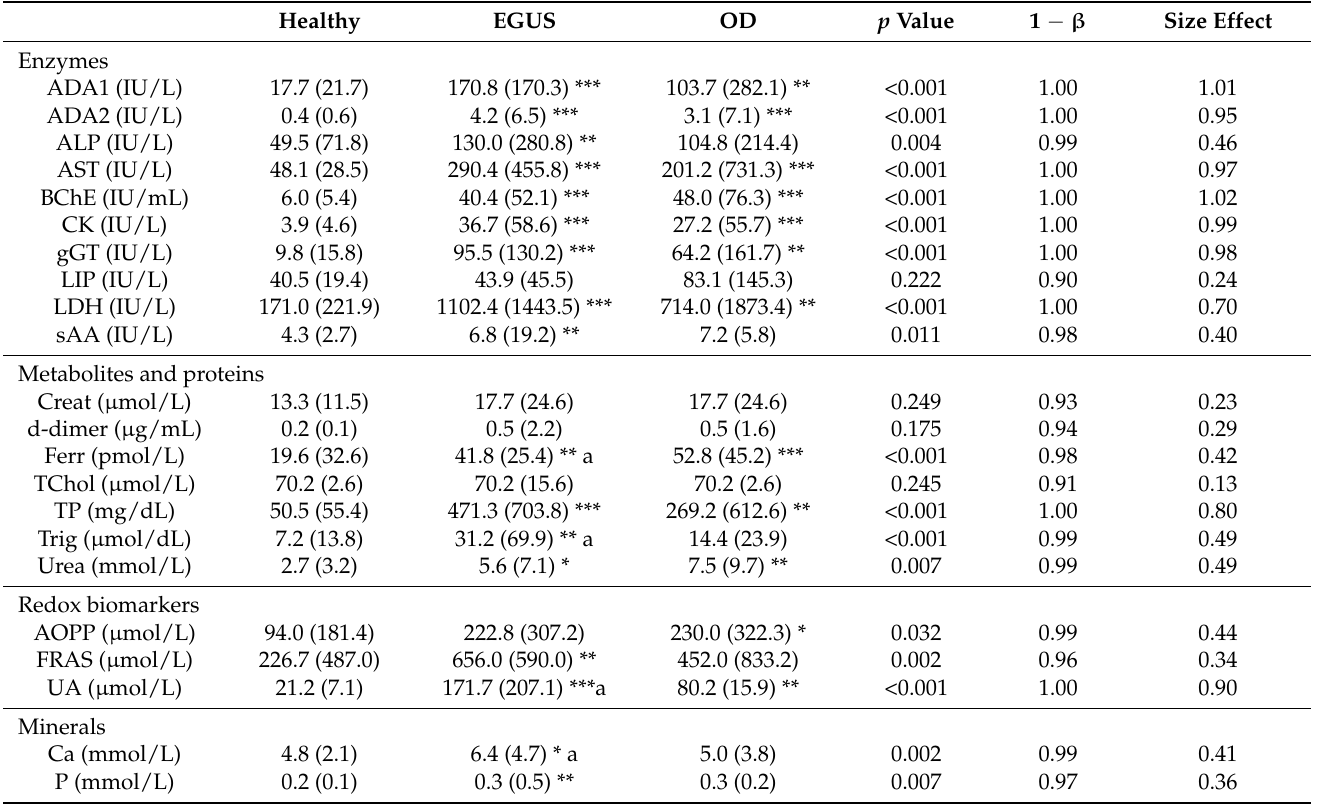
Table 1. Results of salivary analytes in healthy horses ( n = 12), horses diagnosed with EGUS ( n = 110) and horses diagnosed with other gastrointestinal disorders apart from EGUS but with similar symptoms (OD, n = 25). Median (interquartile range) are expressed. Statistical analysis: p value indicates Kruskal–Wallis test result; asterisks indicate Bonferroni post-hoc test significant results with H group (*: p < 0.05 with H; **: p < 0.01 with H; ***: p < 0.001); letters indicate